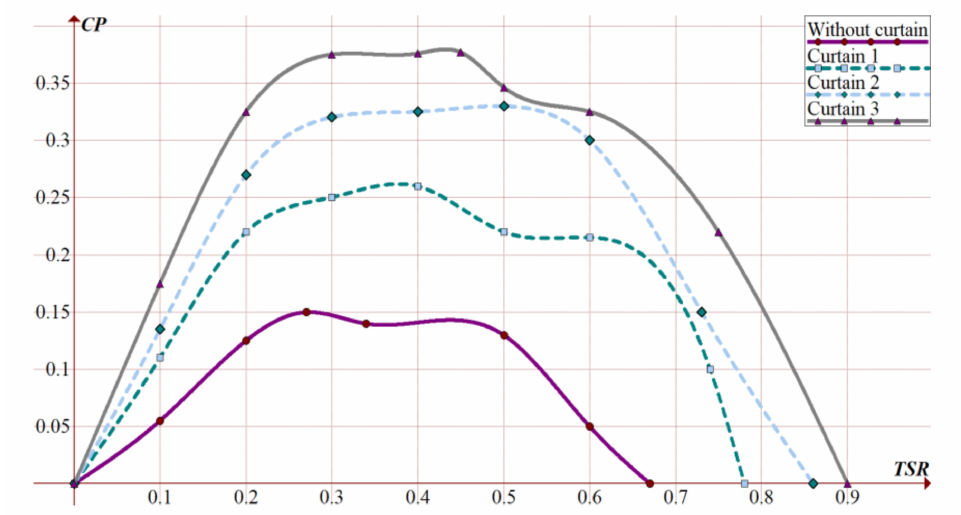
Figure 16. Power coefficient values obtained for the rotor without curtain and with 3 curtain types